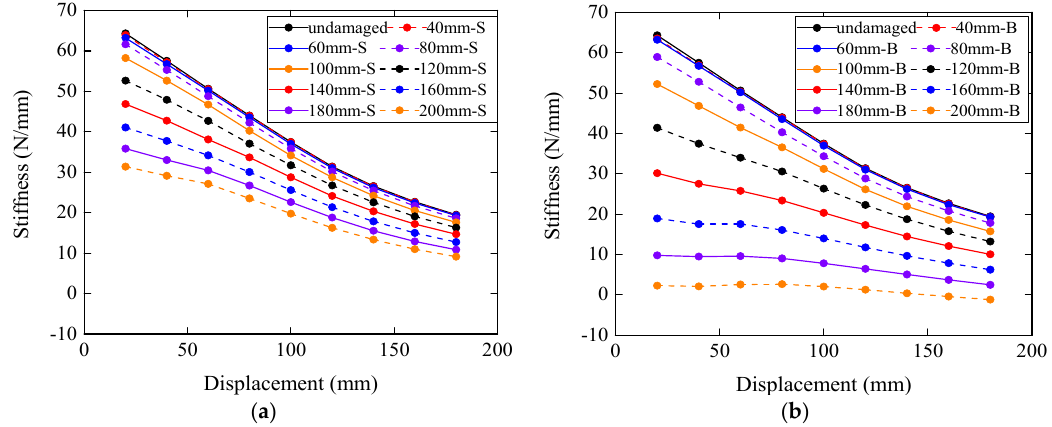
Figure 27. Stiffness of the damaged models: ( a ) Single tenon damaged; ( b ) both tenons damaged.